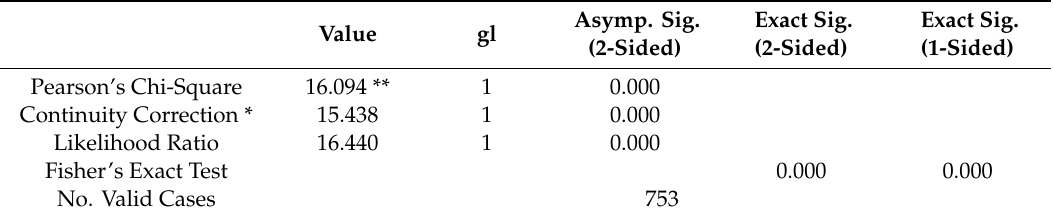
Table 6. Pearson’s Chi-square ( χ 2 ) Test for di ff erences by gender. Asymp. Sig. Exact Sig. Exact Value gl (2-Sided)